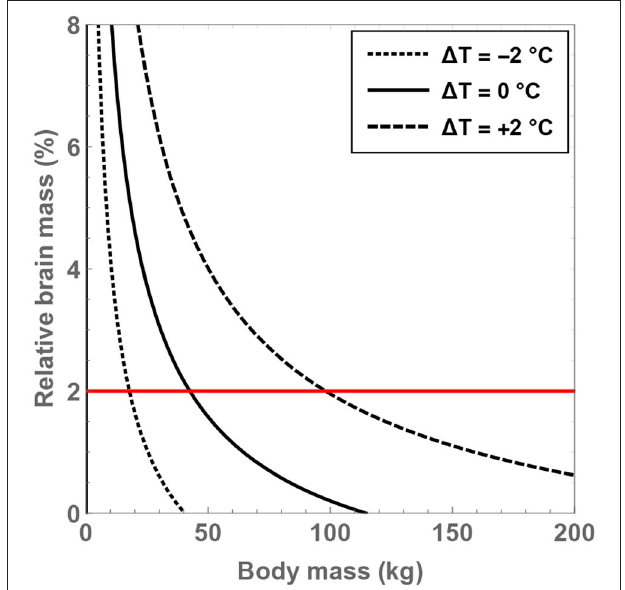
FIGURE 2 | Compatible values of the brain-to-body mass ratio ( δ M ) and body mass ( M BD ) are depicted for putative hominins that take part in 8 h of feeding per day; the regions within the curves are the permitted domains. The dotted, unbroken, and dashed curves correspond to body temperatures that differ from present-day humans by − 2, 0, and + 2 ◦ C; the equivalent body temperatures are 35, 37, and 39 ◦ C, respectively. The horizontal red line is associated with δ M = 2 %